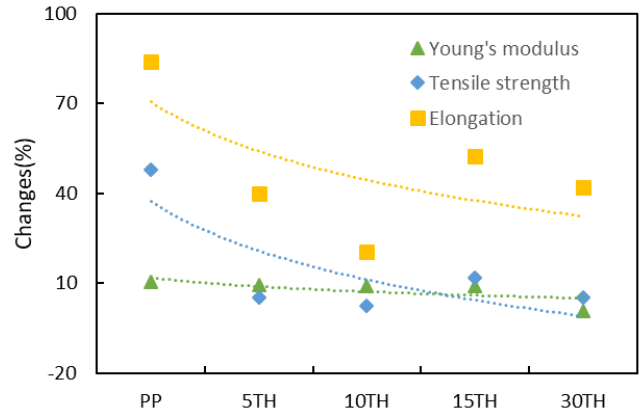
Figure 7. The changes of tensile property on PP and PP/TH composite before and after UV weathering.